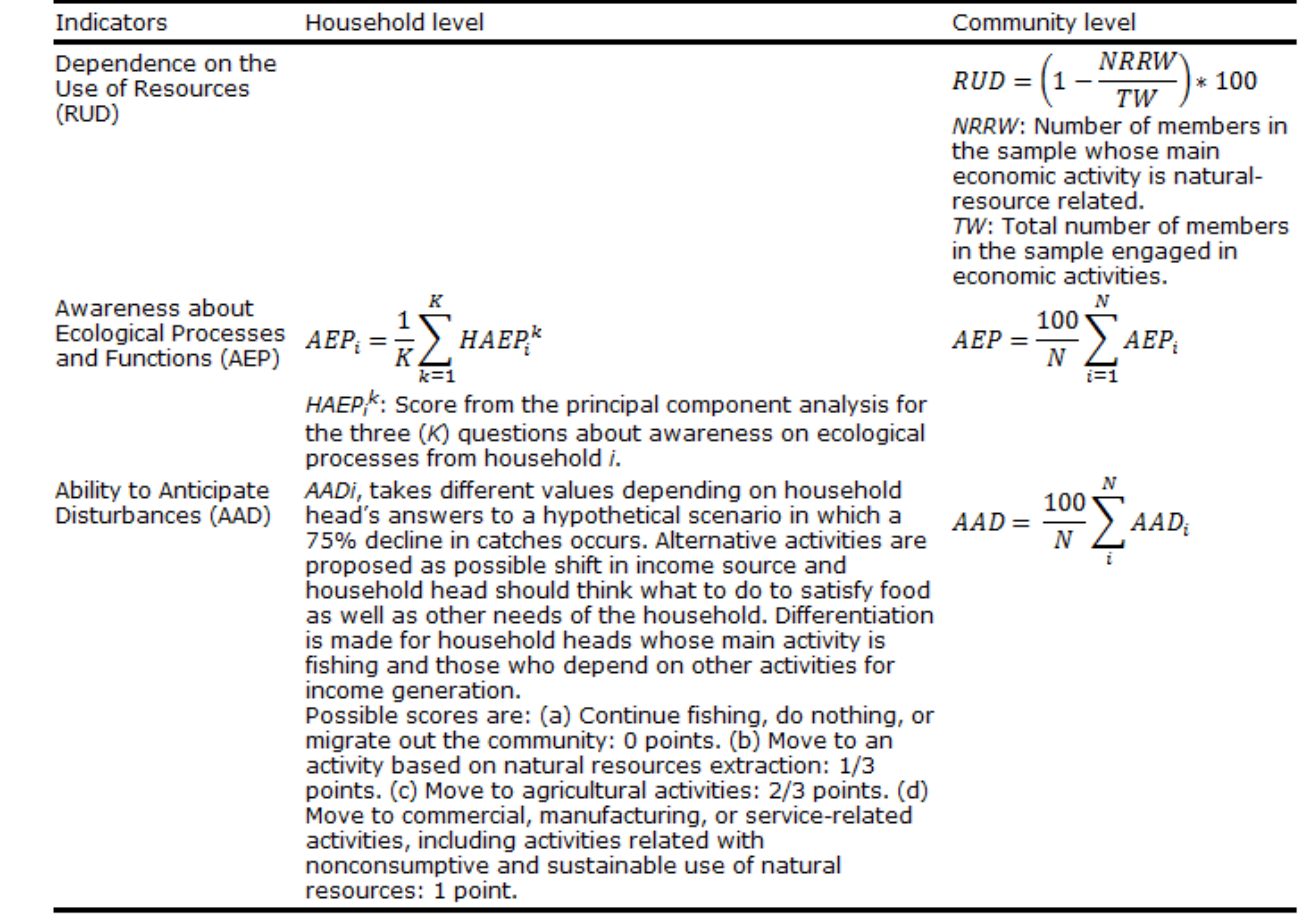
Table 6 . Calculation of social-ecological dimension and its